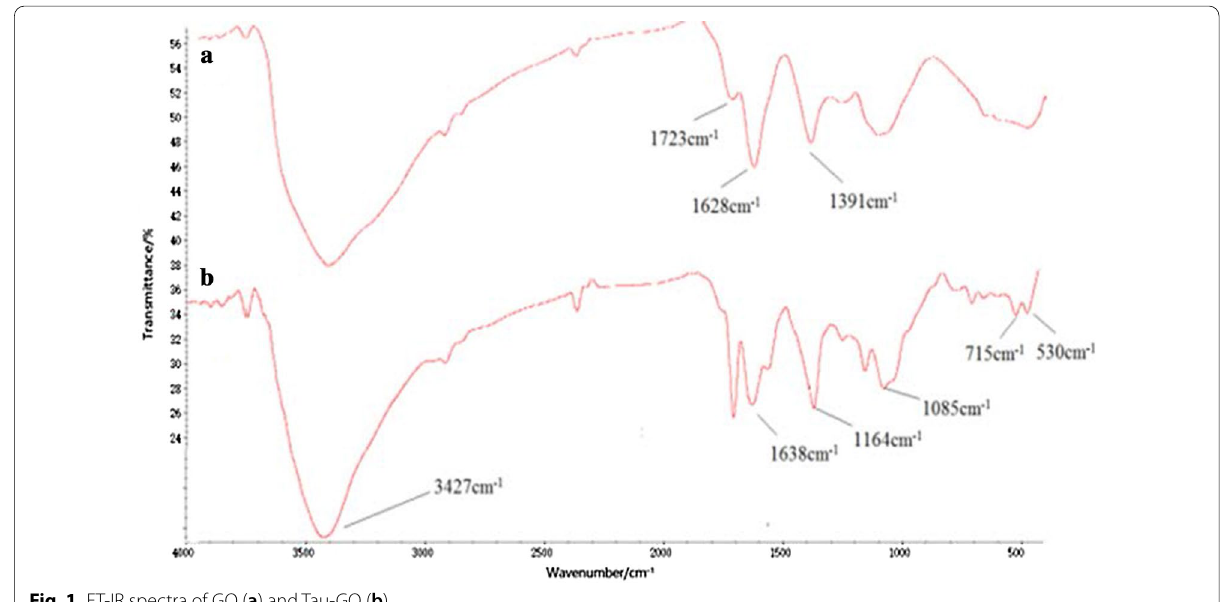
Fig. 1 FT-IR spectra of GO ( a ) and Tau-GO ( b )